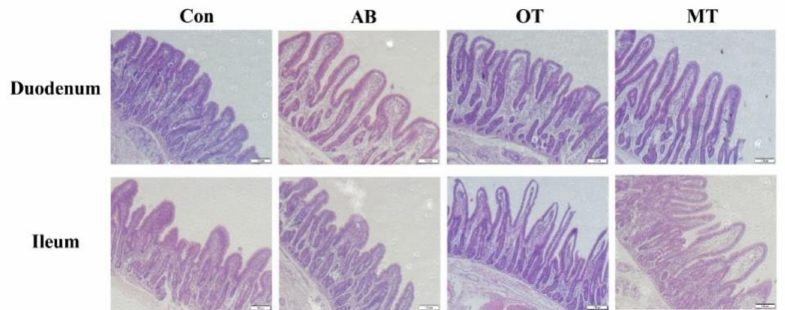
Figure 1. Histological and morphometrical analyses of small intestine by hematoxylin-eosin (H&E) staining. Con, the basal diet without antibiotics, tributyrin, oregano or methyl salicylate; AB diet, the basal diets supplemented with an antibiotic compound, which provides the diet with 120 mg oxytetracycline-calcium and 16 mg enduracidin per kilogram; OT and MT diets, the basal diet supplemented with tributyrin plus oregano (1.4 g and 0.6 g per kilogram diet) and tributyrin plus methyl salicylate (1.4 g and 0.6 g per kilogram diet), respectively. Villus height and crypt depth for the small intestine are in Table 4. The measurement of villus height (from the tip of the villous to villous-crypt junction) and crypt depth (from the villous-crypt junction to the lower limit of the crypt) were recorded as the mean of 10 fields for specimen. Scale bars: 100 µ m.